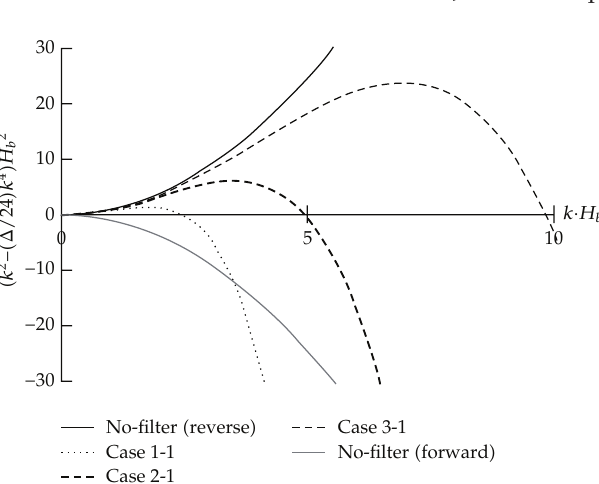
Figure 13: Coe ffi cients of right-hand side of (cid:3) 4.1 (cid:4) , (cid:3) 4.2 (cid:4) , and (cid:3) 4.4 (cid:4) in each wave number (cid:3) Case 1-1, Case 2-1, Case 3-1 (cid:4)